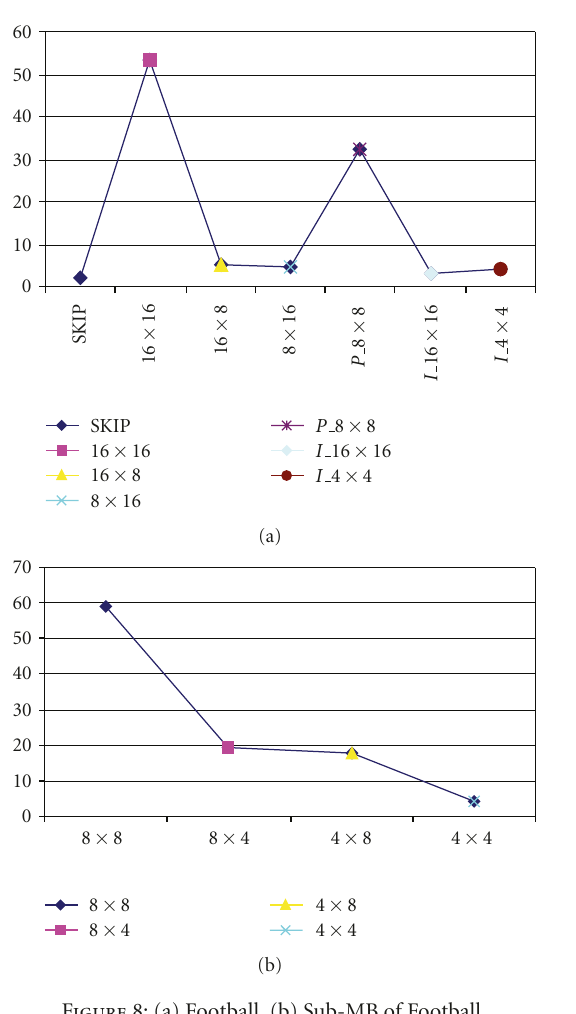
Figure 8: (a) Football. (b) Sub-MB of Football.